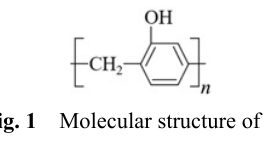
Fig. 1 Molecular structure of